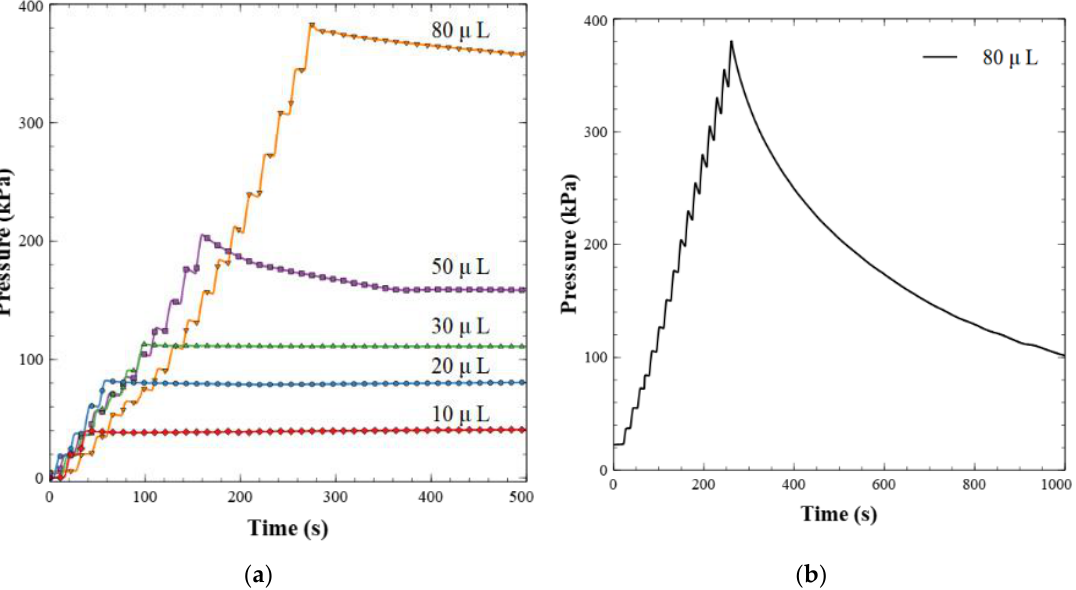
Figure 4. ( a ) Dead-end pressure test for leakage characterization. Fluid is injected backwards into the valve in 5 µL increments and then held after a total volume has been reached as shown. ( b ) Example of a failed valve. The pressure did not hold or stabilize over the 20-min window when fluid was injected backwards into the valve.